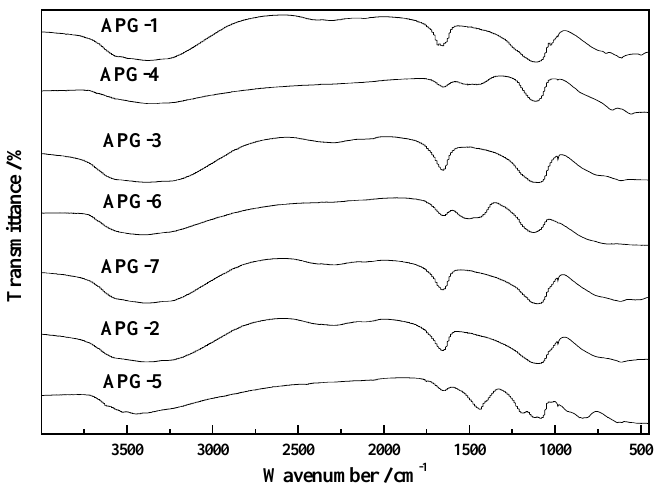
Figure 6. FT-IR spectra of spent sulfur transfer catalysts with different metals.